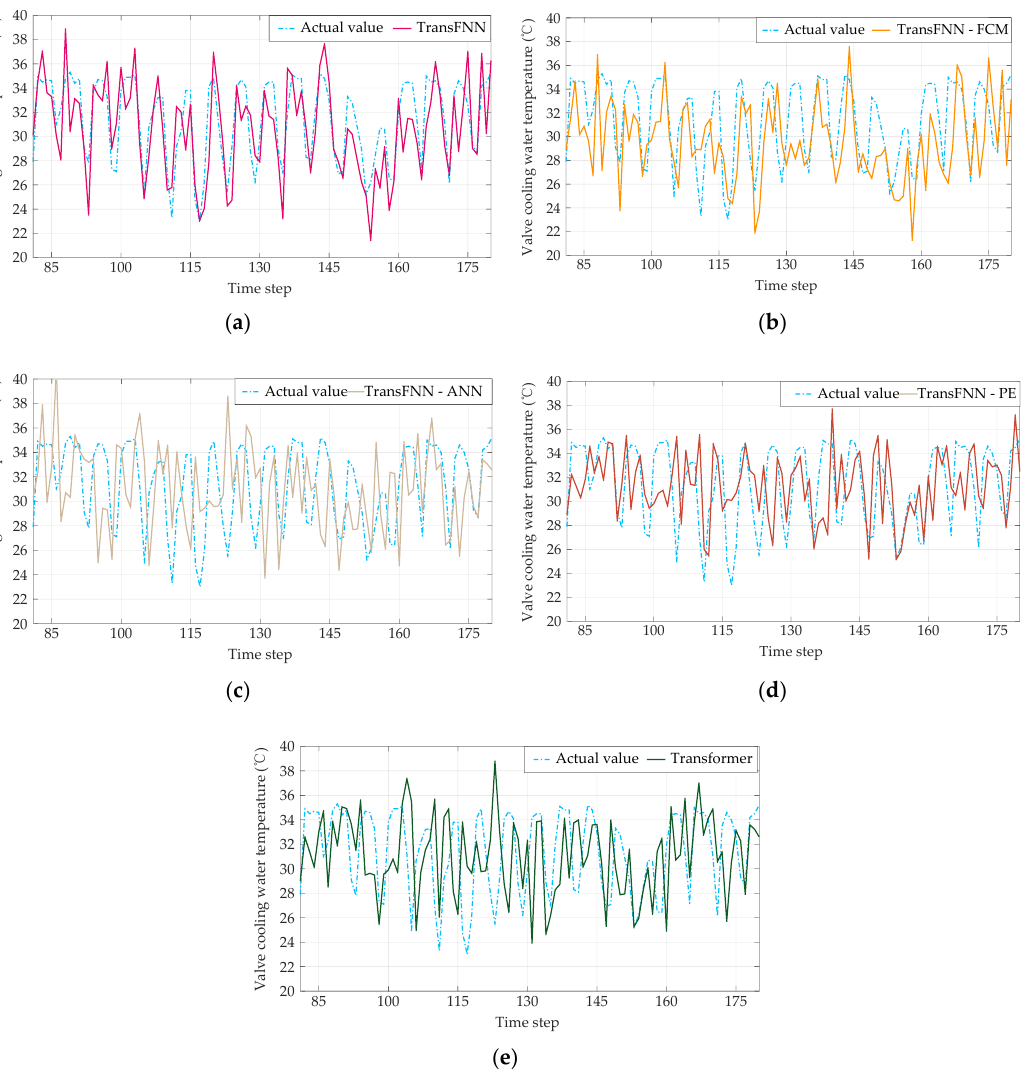
Figure 10. Prediction results of the five models: ( a ) TransFNN ; ( b ) TransFNN − FCM ; ( c ) TransFNN − ANN ; ( d ) TransFNN − PE ; ( e ) Transformer only. Figure